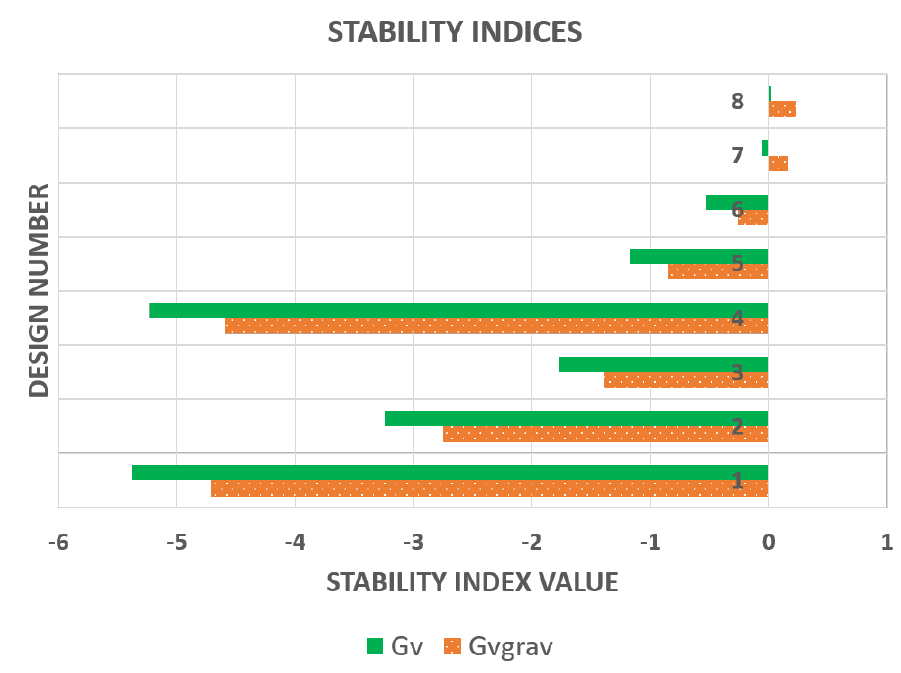
Figure 6. Stability indices for all major designs from least to most stable design.